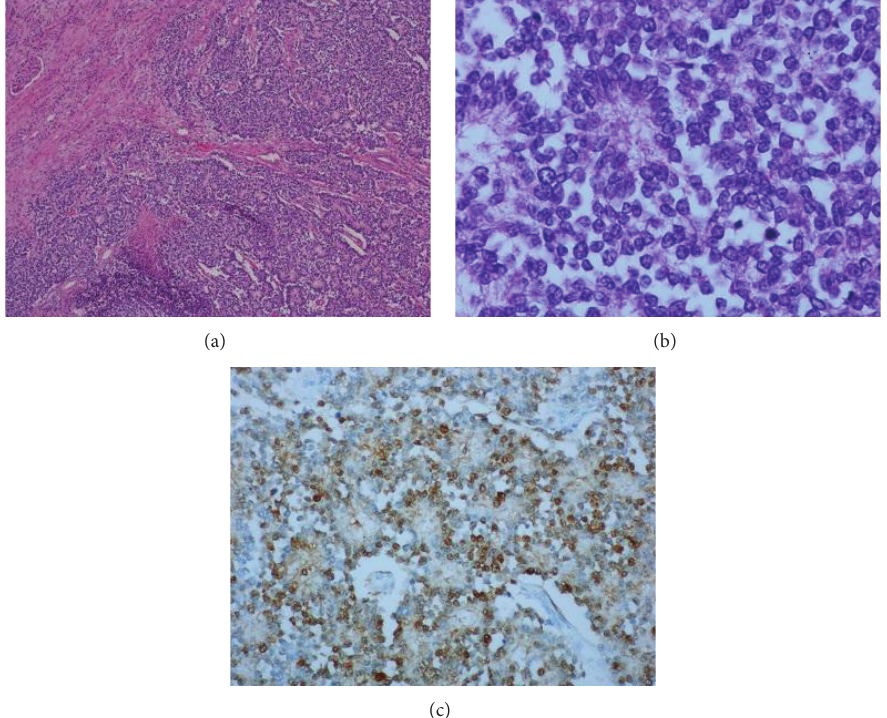
Figure 2: (a) Small blue cells arranged in Homer-Wright rosettes; (b) tumor cells and rosettes, numerous atypical mitoses; (c) tumor cells labeled with anti-S100 protein